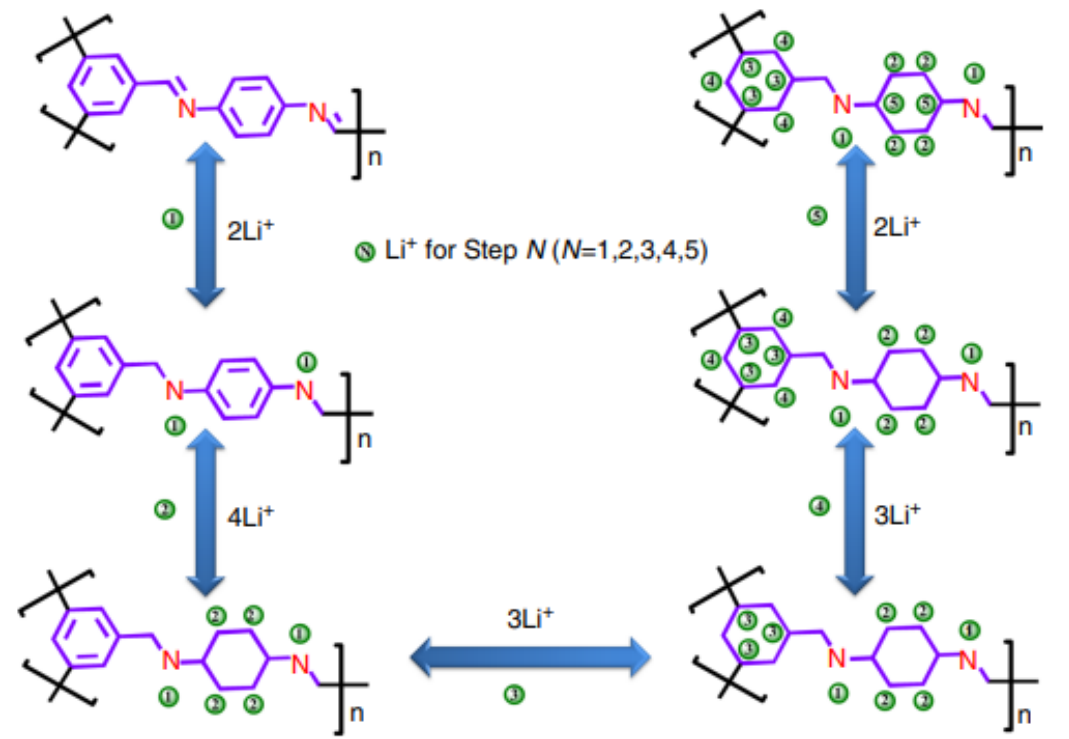
Figure 8. Schematical representation demonstrating the stepwise lithium-storage mechanism for a COF monomer in the COF@CNTs composite anode material [91]. Ref. [91] is an open-access article